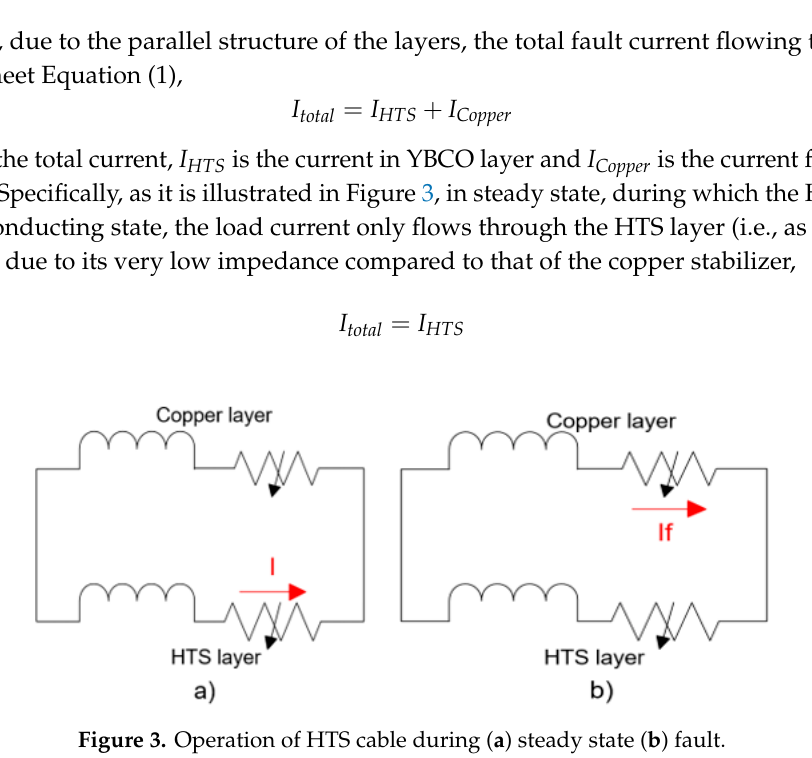
Figure 3. Operation of HTS cable during ( a ) steady state ( b ) fault.